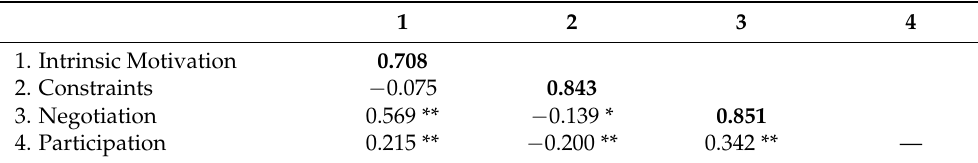
Table 2. Correlation estimates of